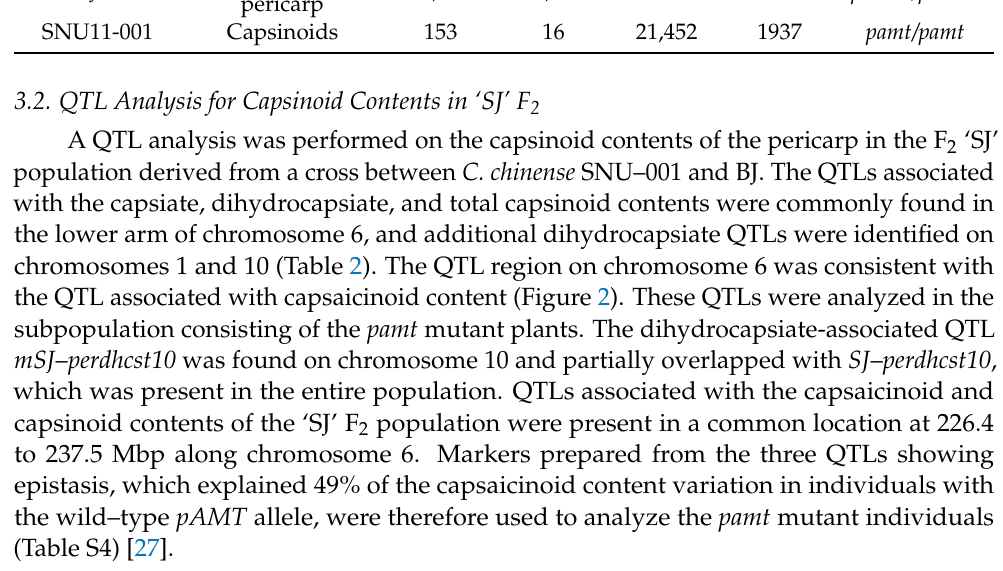
Table 2. QTLs associated with the capsinoid contents in the pericarp of the entire ‘SJ’ F 2 population and pamt mutant plants. Segregation